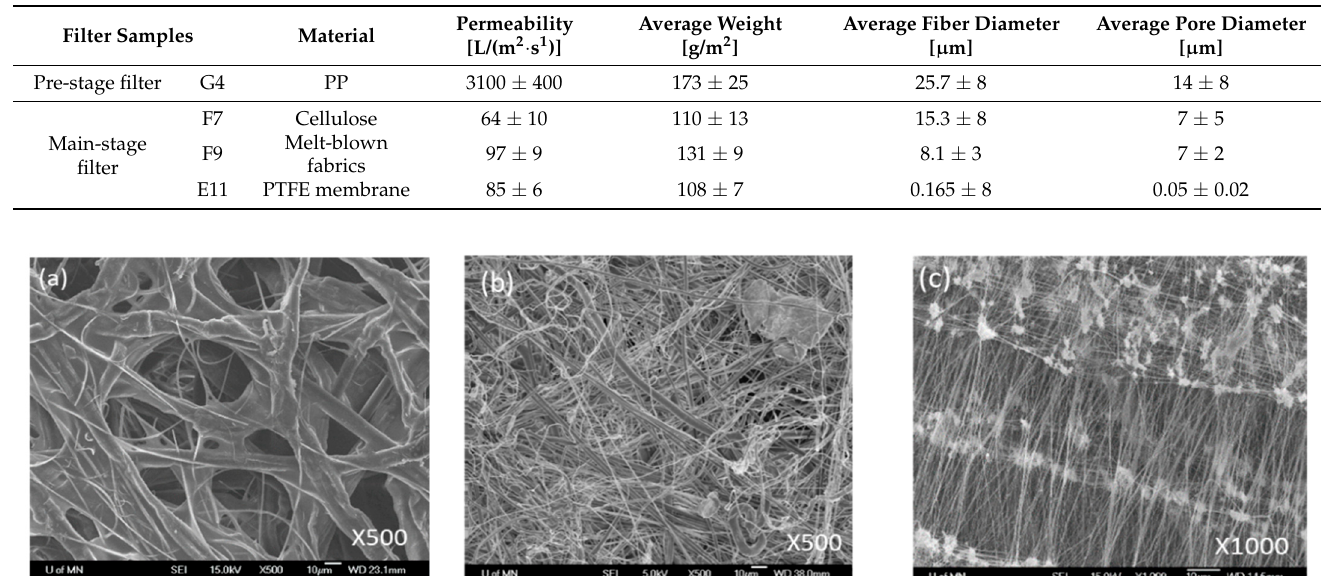
Figure 2. Oil contact angle of filter samples. ( a ) F7 cellulose filter, ( b ) F9 melt-blown filter, ( c ) E11 PTFE membrane-coated filter. Two types of testing particles were used to mimic both the oil and solid modes in var- ious conditions. A2 fine dusts (ISO 12103-1) represent the coarse solid particles which were dispersed by a homemade dust disperser. The concentration of A2 fine particles was con- trolled by adjusting the dust feeding rate at the ejection pump which was used to deagglom- erate dusts. Dioctyl sebacate (DEHS) was chosen as the raw material to generate the fine oil particles, in which the viscosity and the surface tension of DEHS were 26.2 Pa·s and 3.03 × 10 − 2 N/m, respectively. DEHS was atomized by an aerosol nebulizer (Model 3076, TSI Inc., Shoreview, MN, USA). The concentration of DEHS particles was adjusted via regulating the inlet flow from a mass flow controller. To simulate designated distributions of oil– dust mixed particles, corresponding doses of DEHS oil particles and A2 solid particles were mixed in this study accordingly. The particle size distribution of DEHS fine and A2 coarse dust particles can be found in Figure 3. To facilitate the calculations, the gained weight of DEHS particles was replaced by the equivalent weight of A2 particles, as shown in Equation (1), and the concentration of emitted particles is written as Equation (2), i.e., △ m′ (cid:2888)(cid:2889)(cid:2892)(cid:2903) = △ m (cid:2888)(cid:2889)(cid:2892)(cid:2903) ρ (cid:2888)(cid:2889)(cid:2892)(cid:2903) · ρ (cid:2885)(cid:2870)